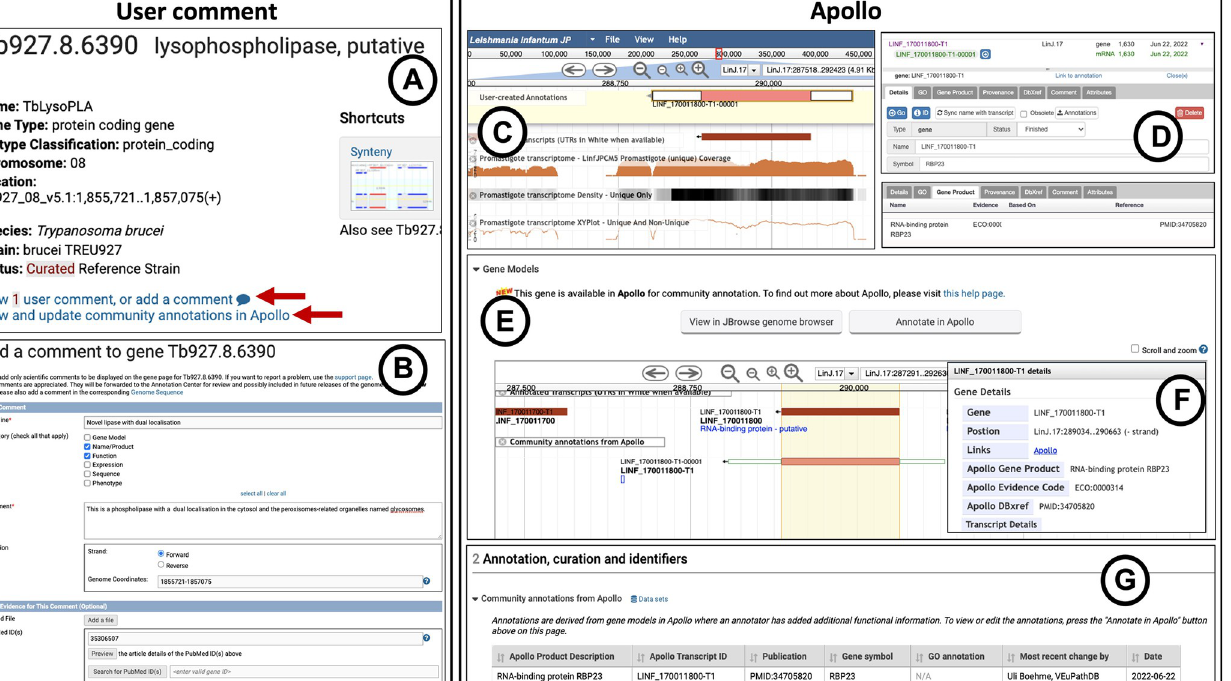
PLOS NeglectedTropical Diseases | https://doi.org/10.1371/journal.pntd.0011058 January 19,